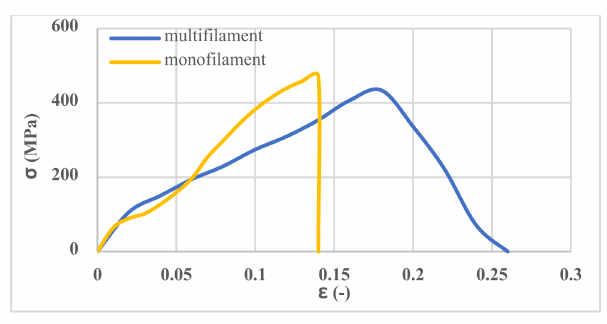
Figure 5. Tensile stress–strain curves of various yarns.